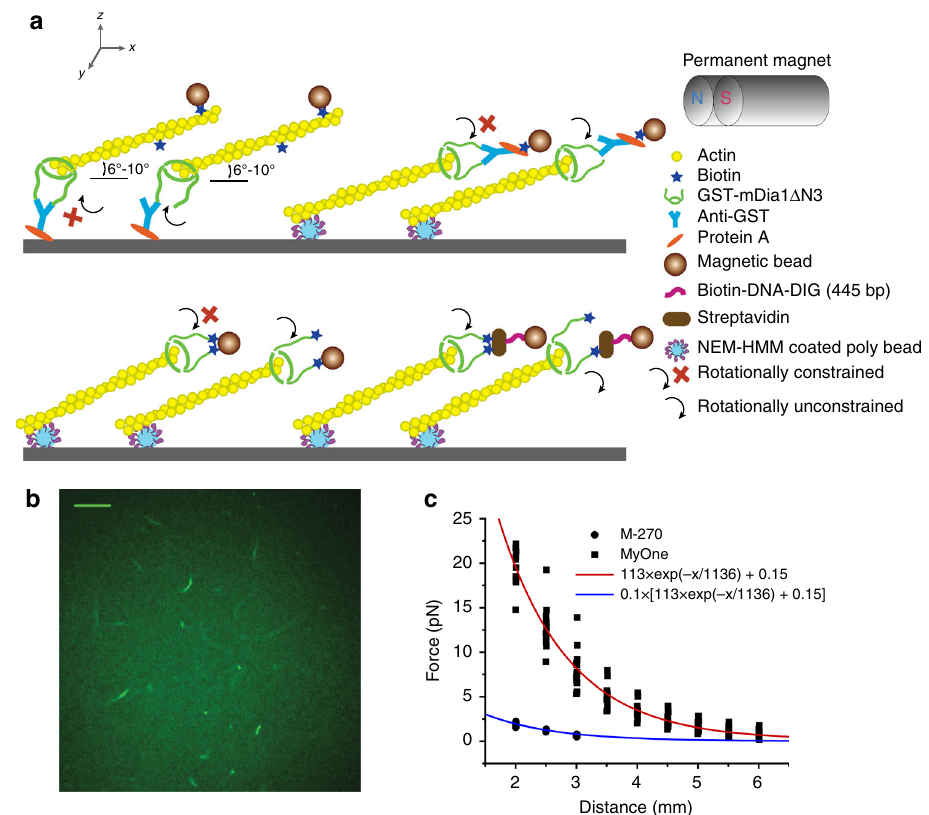
Fig. 1 Schematics of experimental set-up and force calibration. a Actin fi laments are tethered in four different designs using two differently tagged mDia1 Δ N3. The GST-mDia1 Δ N3-bound barbed end of the fi lament is either attached to an anti-GST – Protein A coated coverslip surface (top-left) or to an anti-GST – Protein A coated superparamagnetic bead (top right). The biotin-mDia1 Δ N3-bound barbed end is attached to a streptavidin-coated superparamagnetic bead either directly (bottom left) or indirectly (bottom right) through a torsionally unconstrained DNA linker. The actin fi lament is tethered to an immobilized NEM-HMM-coated bead on a coverslip through a point on the actin fi lament somewhere near the tipped end. The actin fi lament was stretched at 6 – 10° above the surface using transverse magnetic tweezers. The rotationally unconstrained or constrained tethers are indicated. b Fluorescence imaging revealed sparsely distributed seeding fi laments on the surface under our preparation conditions. Scale bar represent 10 μ m. c The calibrated force-distance pro fi les for 2.8- μ m-diameter M270 beads and 1.0- μ m-diameter MyOne beads. 12 beads for M270 and 10 beads for